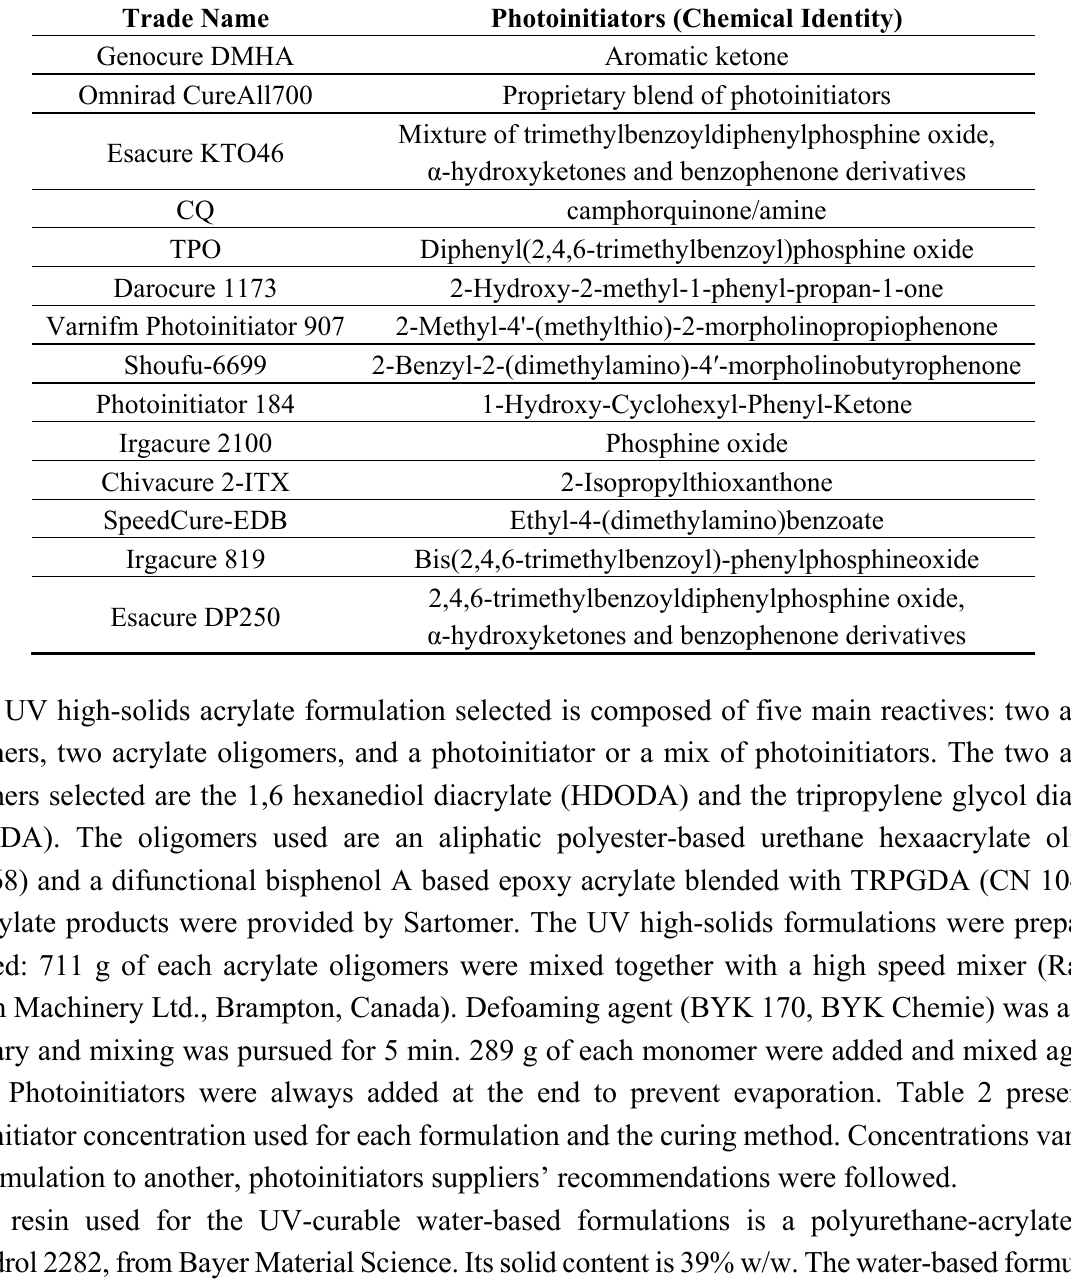
Table 1. Chemical identity and trade name of the photoinitiators